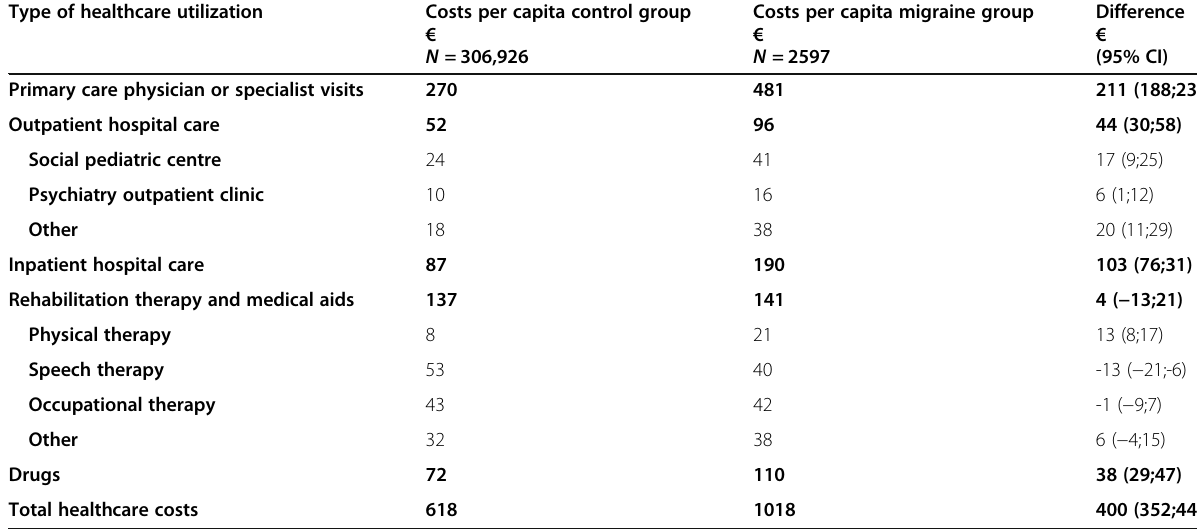
Table 2 Comparison of raw costs in 2017 for control group and migraine group by type of healthcare utilization. CI: confidence interval Type of healthcare